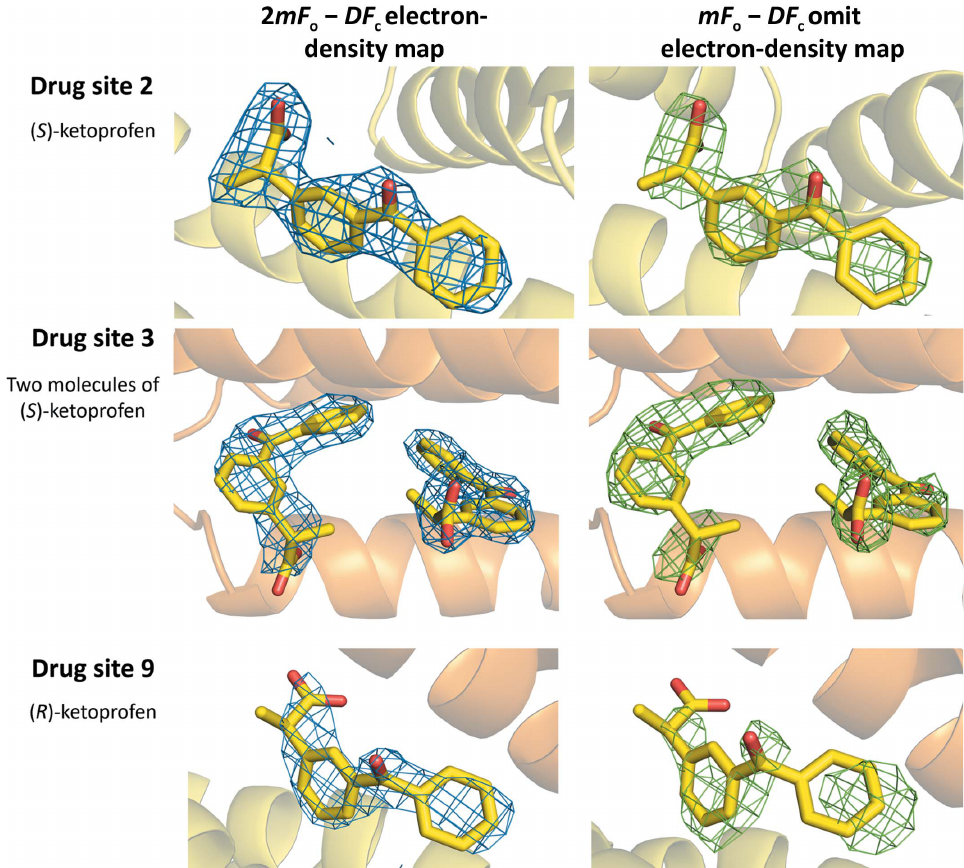
Figure 3 Ketoprofen binding sites in HSA (PDB entry 7jwn). The 2 mF o (cid:2) DF c electron-density map (r.m.s.d. of 1.0 A˚ ) is presented in blue and the mF o (cid:2) DF c omit electron-density map (map calculated after ten REFMAC refinement cycles without the drug in the model, r.m.s.d. of 2.5 A˚ ) is presented in green. Ketoprofen molecules are shown in stick representation with O atoms in red and C atoms in yellow. The colors of the helices correspond to the colors used in Fig. 2. The electron density and the model can be inspected interactively at https://molstack.bioreproducibility.org/project/view/